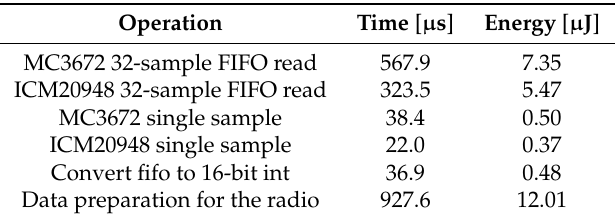
Table 8. Peripheral operations cost.